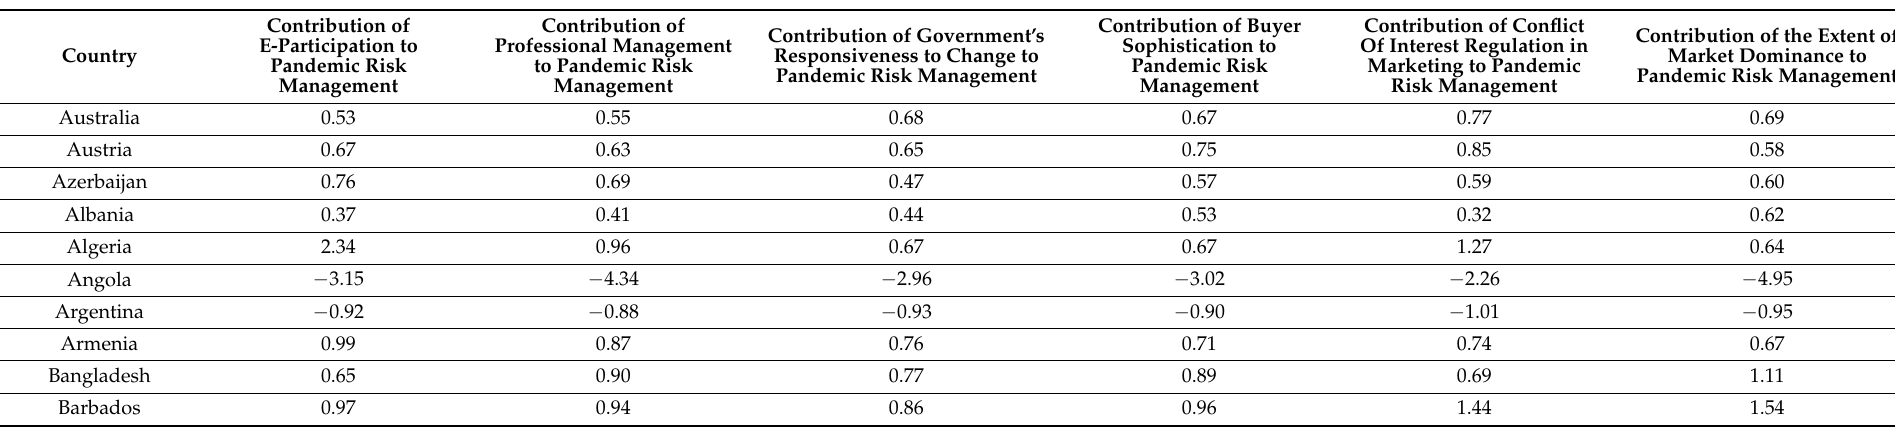
Table A6. Contribution of individual management and marketing factors to the pandemic risk management in the third trimester of